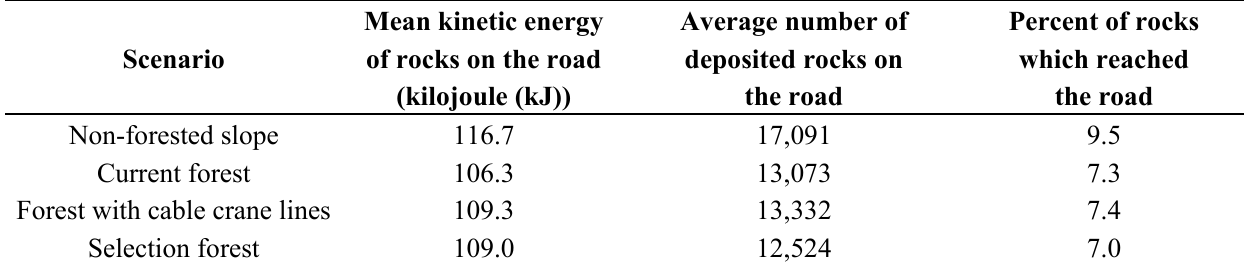
Table 3. Comparison of rockfall susceptibility of regional road between different forest management scenarios (scenario with 1.362.000 released